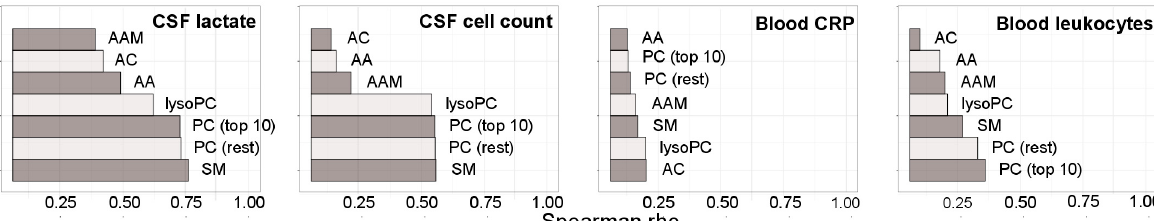
Figure 3. Correlations of the CSF metabolites in bacterial meningitis with CSF and blood parameters. Correlations (mean Pearson correlation coefficient) in 33 bacterial meningitis samples of the indicated metabolite classes with CSF lactate, CSF cell count, blood CRP, and blood leukocytes. Correlations with the remaining parameters are shown in Figure S5. Abbreviations: AA, amino acids; AAM, amino acid metabolites; AC, acylcarnitines; lysoPC, lysophosphatidylcholines; PC, phosphatidylcholines; SM, sphingomyelins.